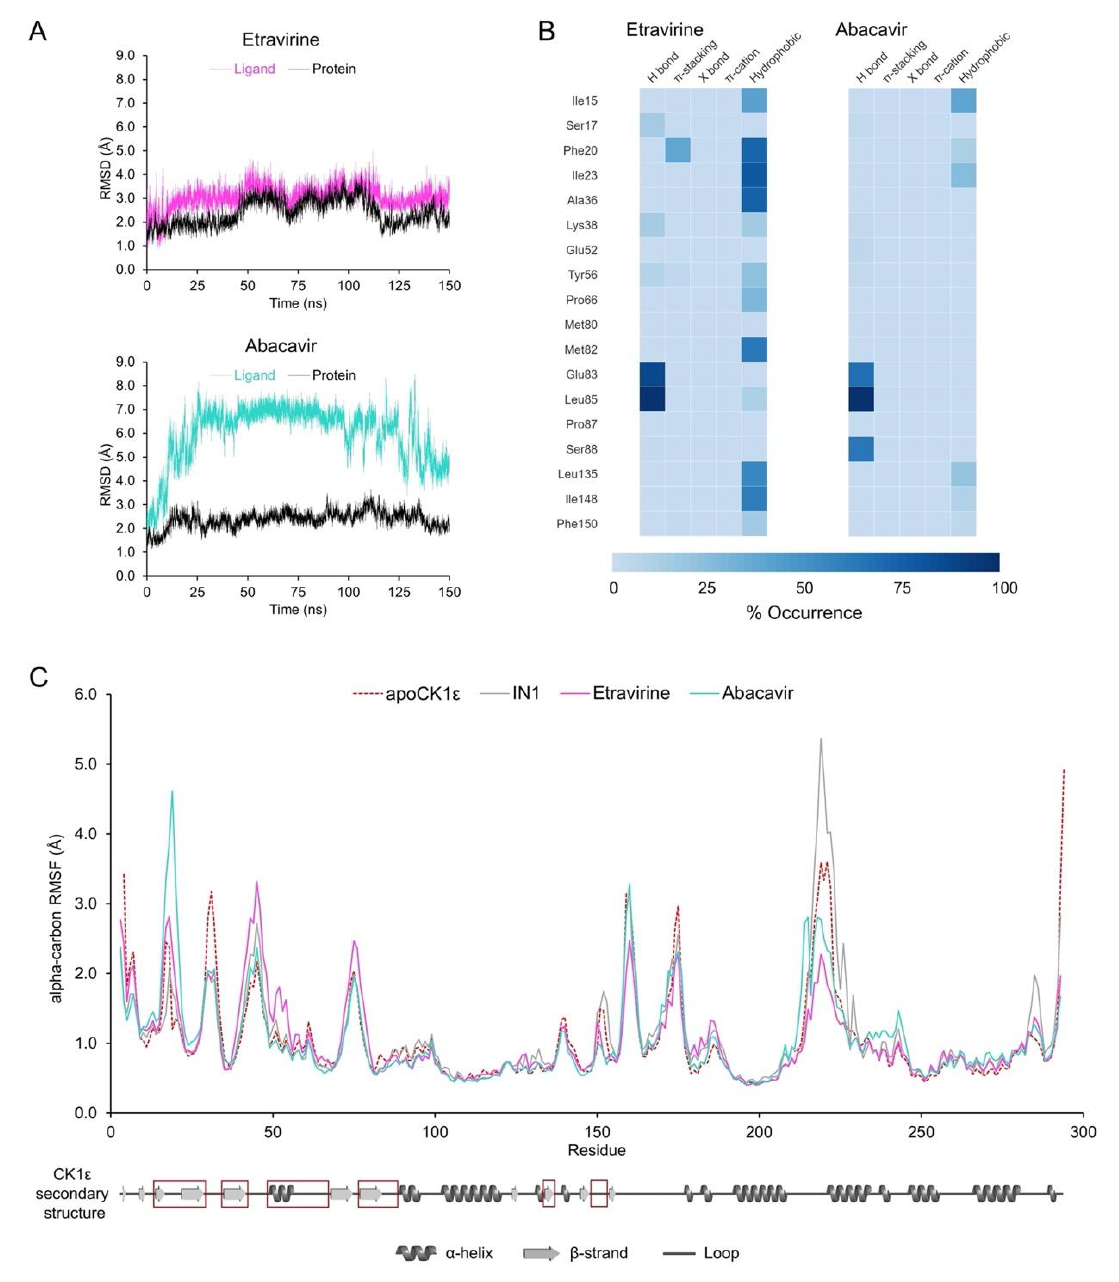
Figure 6. MD analyses for CK1 ε -etravirine and CK1 ε -abacavir complexes. ( A ) Protein backbone (black) and ligands (colored) RMSDs. ( B ) Heatmap of the non-covalent interactions occurrence for selected residues. ( C ) Protein backbone RMSF. The apo enzyme and the system CK1ε-IN1 are shown for comparison. Secondary structure of CK1ε is shown at the bottom with the catalytic domain in red squares.